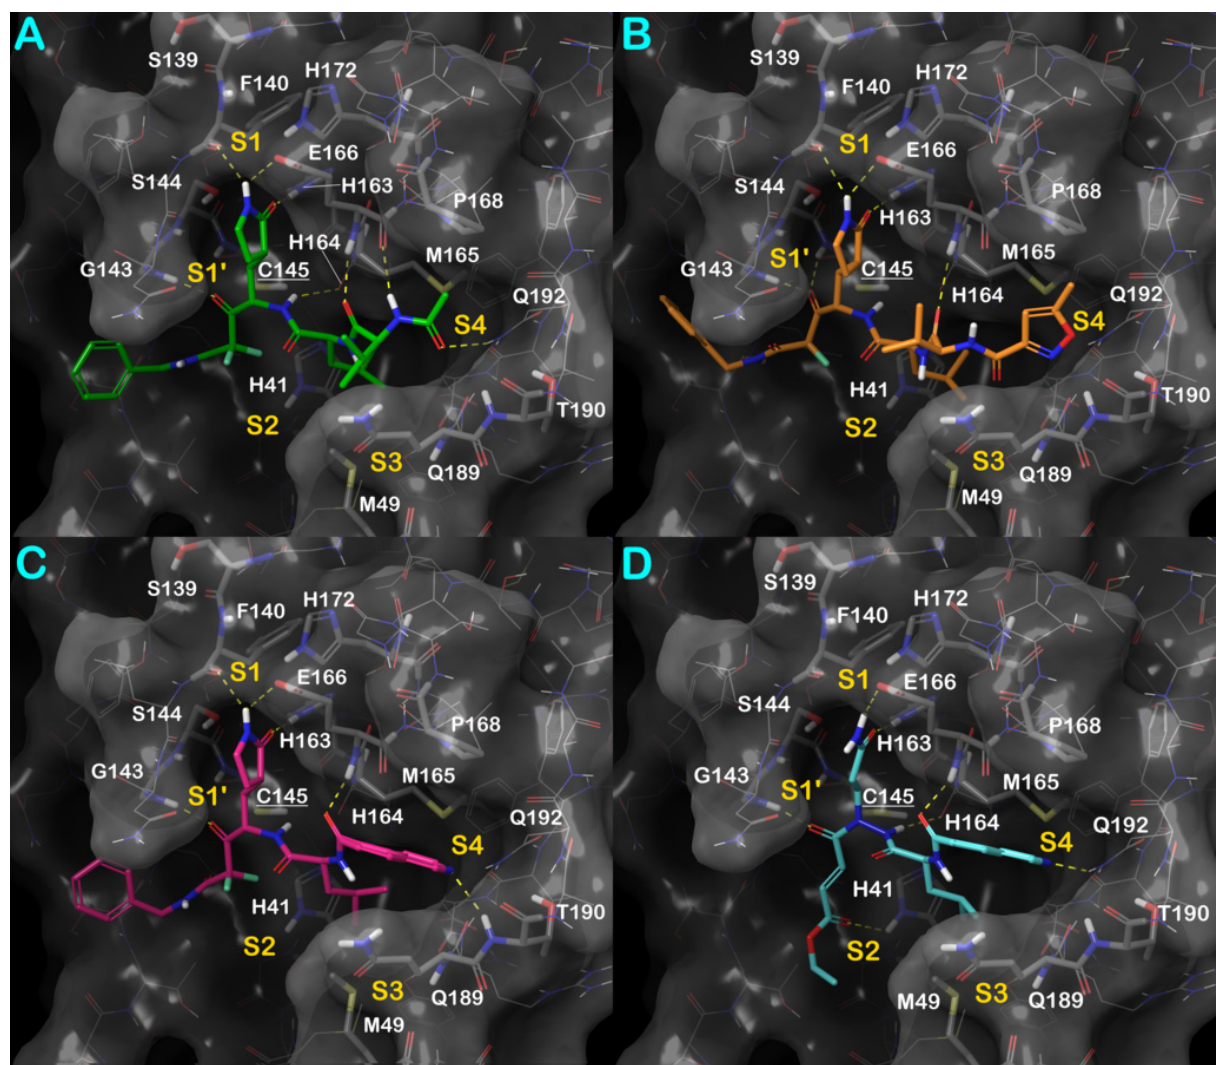
Figure 3. Docked pose of compounds 4 – 7 (panels A – D , respectively) into M pro -SARS-CoV-2 (PDB ID: 6Y2G). Key interacting residues from different regions are represented by sticks and labeled. H- bonds are represented as yellow dotted lines. Pictures were generated by Maestro (Maestro, Schrödinger LLC, release 2020-3).